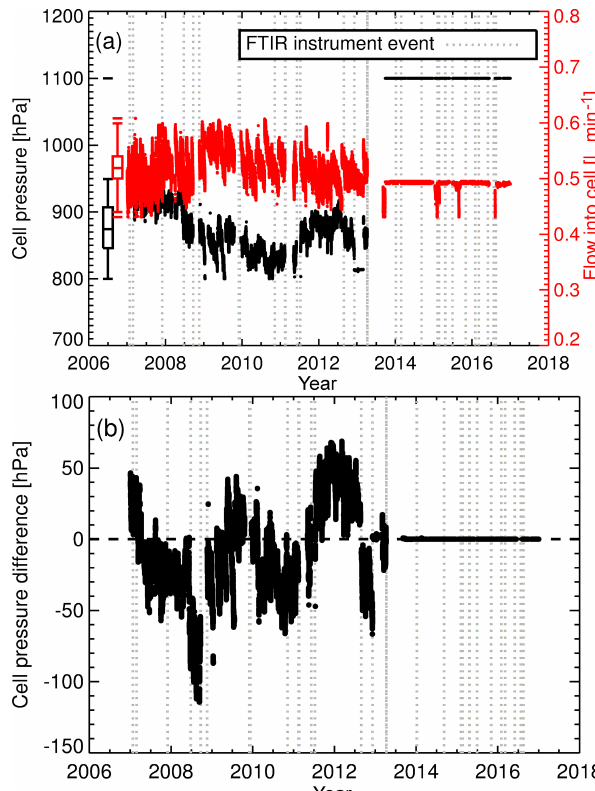
Figure 4. (a) Cell pressure (black) and cell flow rate in flow mode (red) during air-sample measurements. After the April 2013 up- grade, the flow rate is set to 0.5Lmin − 1 and cell pressure is set to 1100hPa. The sudden drop in flow rate on three occasions (post up- grade) are due to MFC power supply faults. Data taken during such faults are filtered out. Overlaid are box plot statistical summaries for cell pressure and flow rate prior to the April 2013 upgrade. (b) Dif- ference between air sample and WS cell